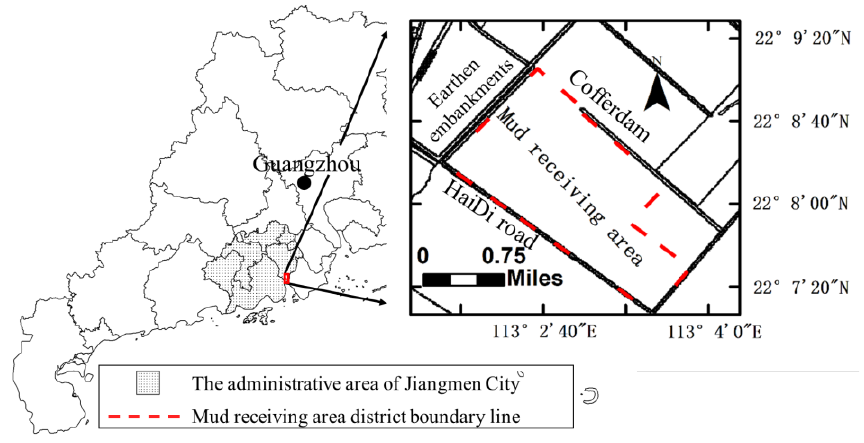
Figure 1. The geographical location of the study area.